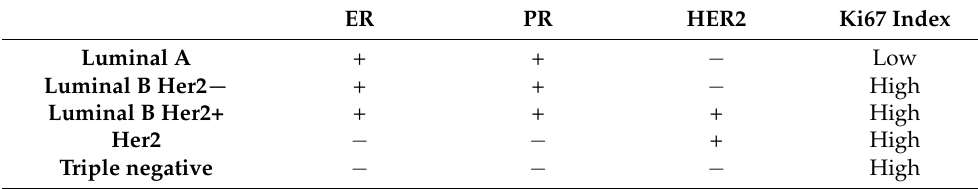
Table 1. Breast cancer molecular subtype. ER: estrogen receptor, PR: progesterone receptor. ER PR HER2 Ki67